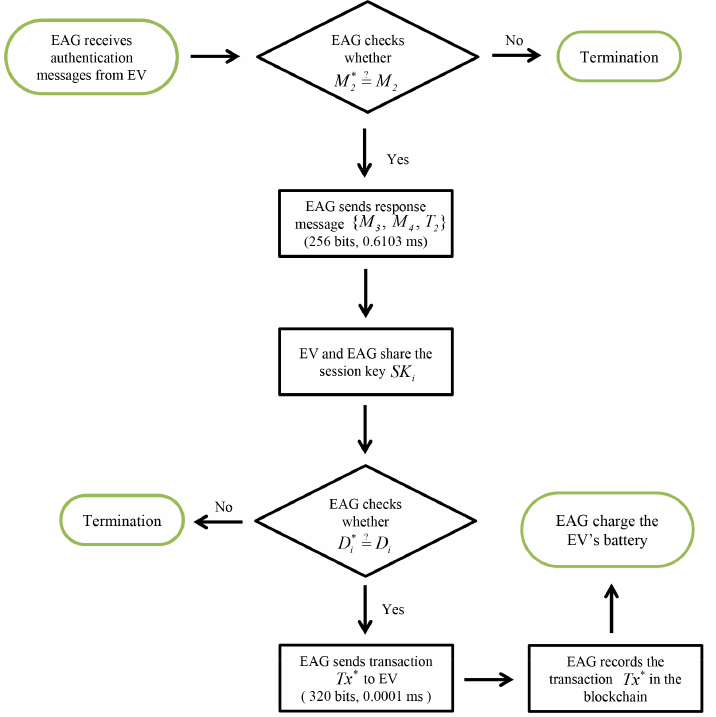
Figure 16. Actual data workflow of EAG.